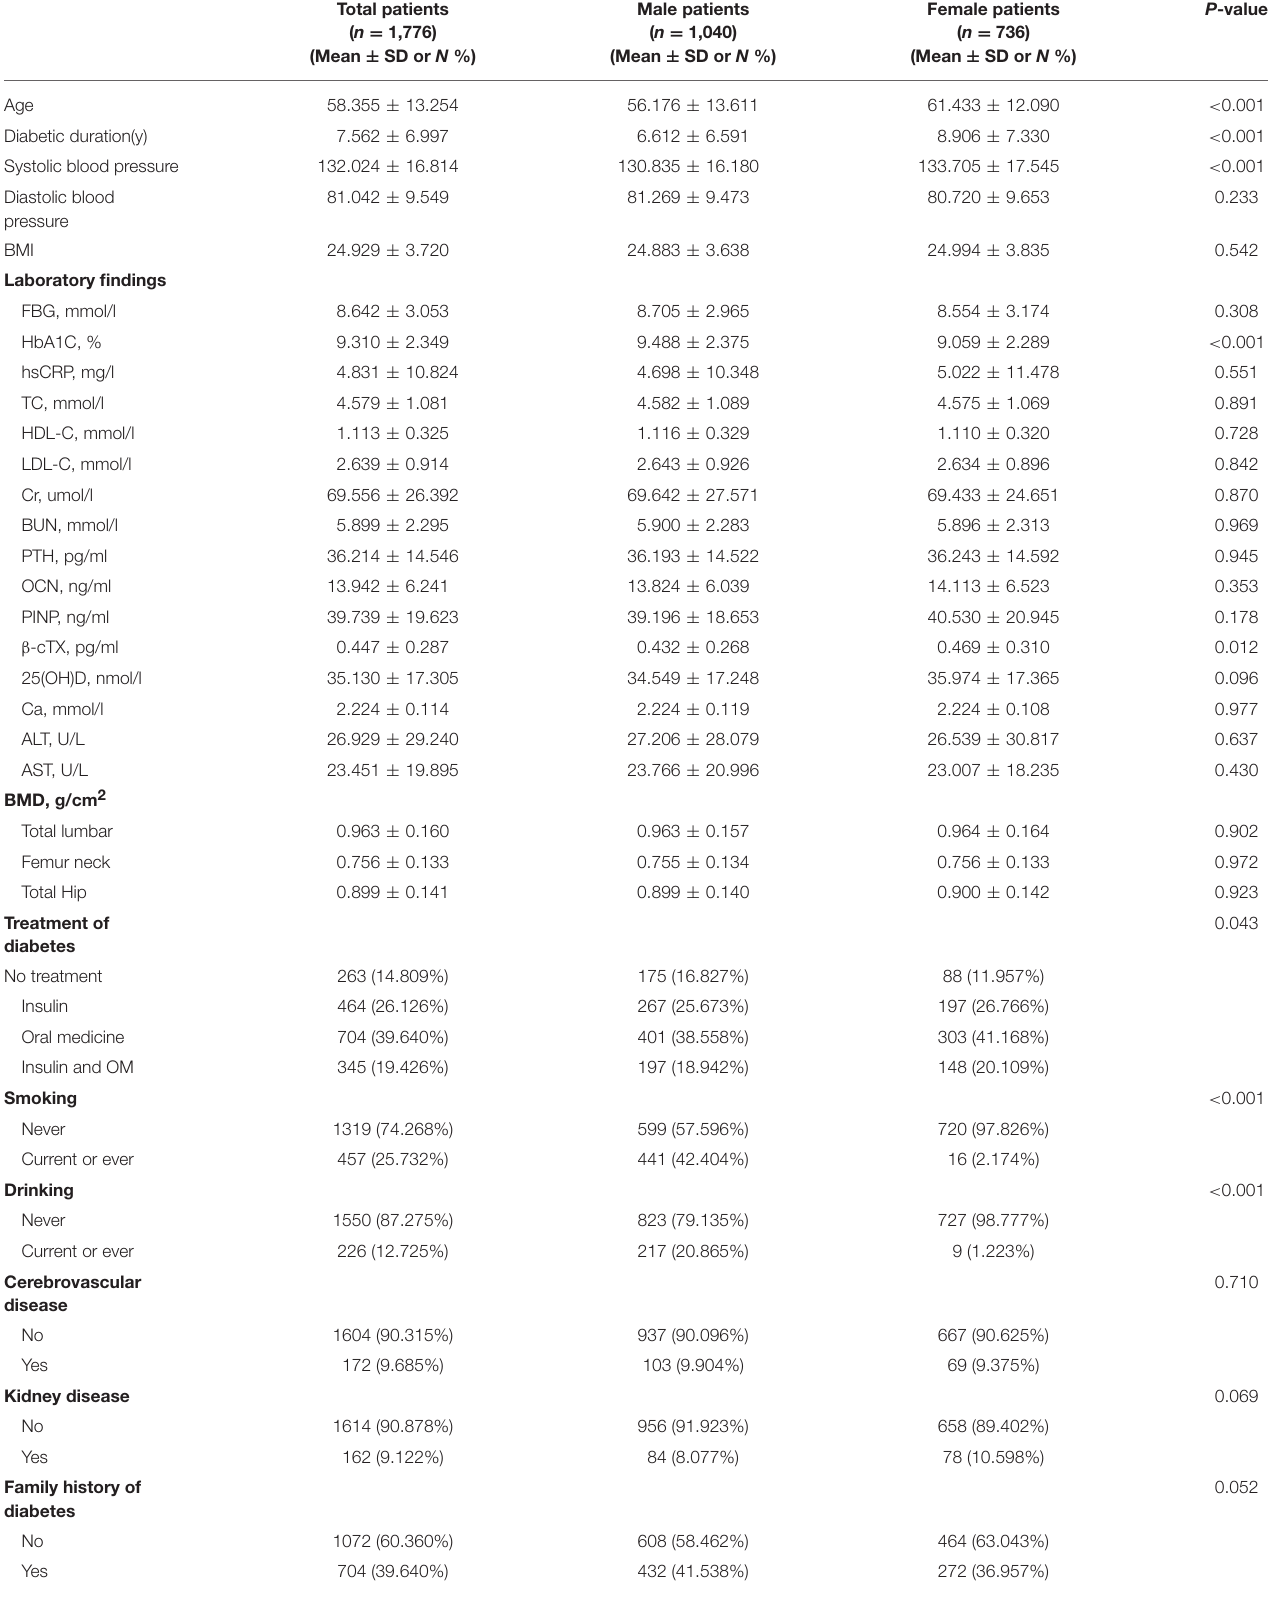
TABLE 1 | Patient characteristics, stratified by sex. Values are mean ± SD or n (%) unless otherwise